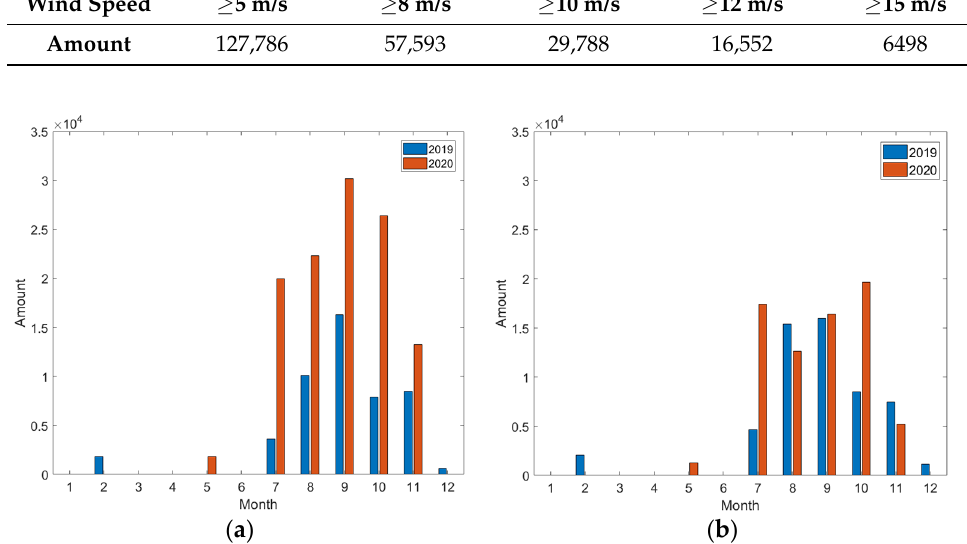
Table 2. Data quantity of different wind speed ranges.